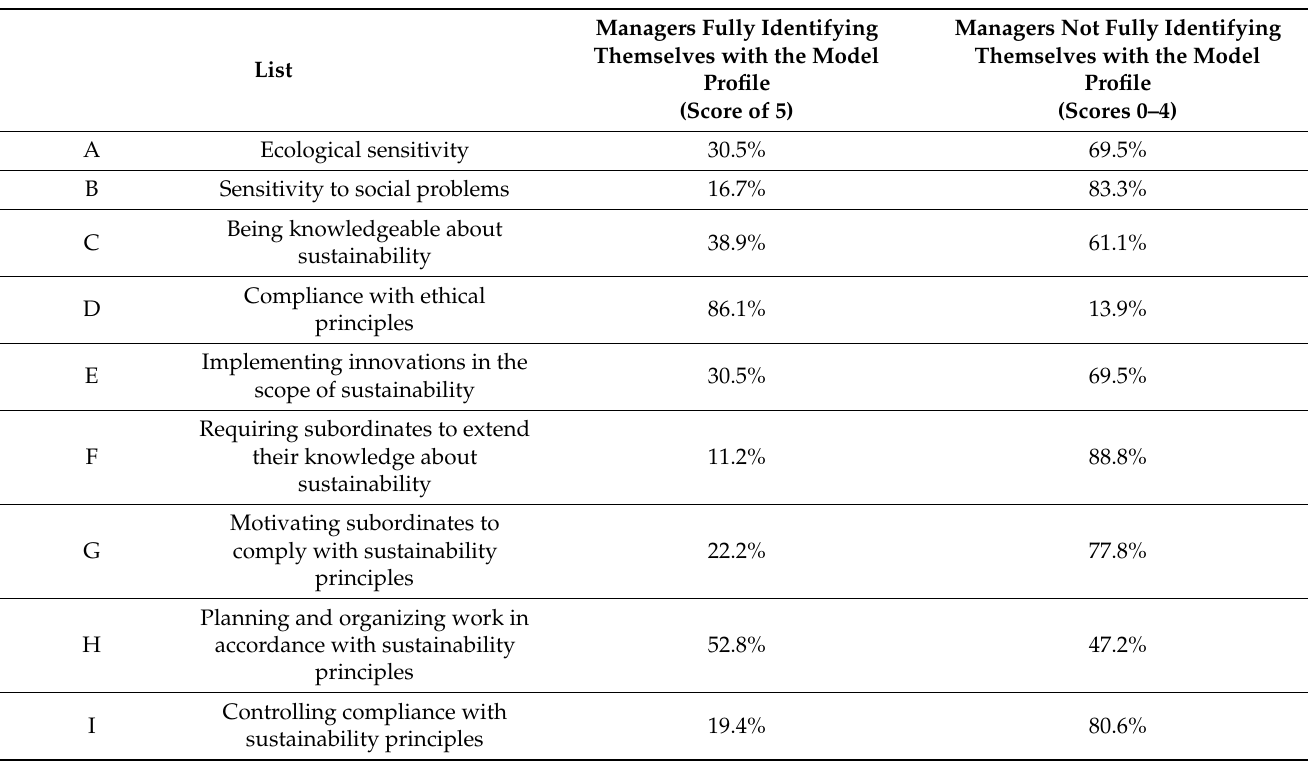
Figure 1. Model sustainable manager profile versus the sustainable manager profile in the opinion of energy companies’ managers. SD—sustainable development. Source: own research. Table 3. Discrepancy in the scope of the model sustainable manager profile and opinions of energy companies’